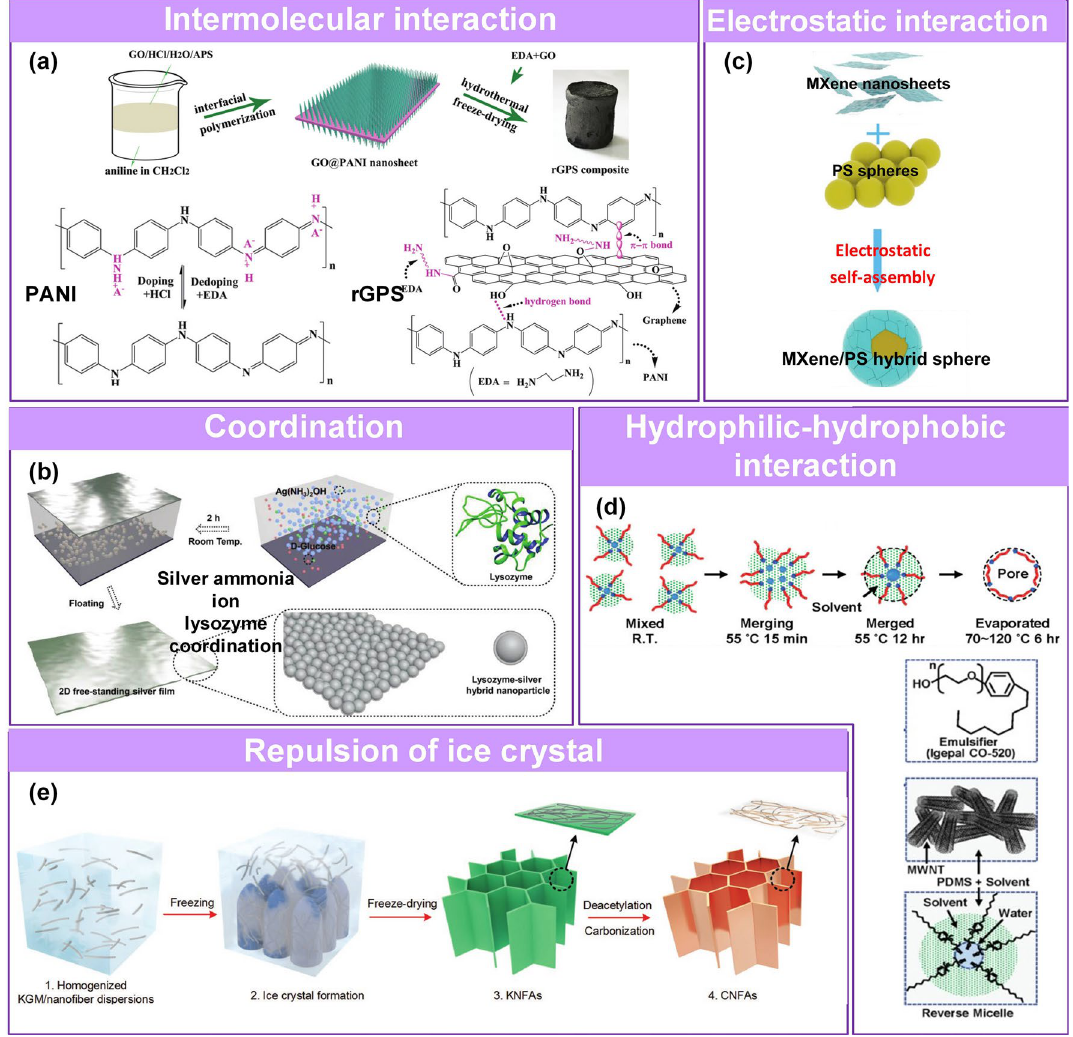
Fig. 13 Self-assemble synthesis of structured sensing materials. Self-assembly process based on a Intermolecular interaction of the interac- tions of π–π interaction action and hydrogen bond between GO sheets and PANI nanowires [111]. Copyright (2019) Royal Society of Chemistry. b Coordination of Ag NPs and protein at the air/water interface [112]. Copyright (2018) Wiley–VCH. c Electrostatic interaction between PS sphere and MXene [113]. Copyright (2019) Wiley–VCH. d Hydrophilic-hydrophobic interaction to form micelles [26]. Copyright (2014) Wiley– VCH. e Honeycomb-shaped structure guided by growth and repulsion of ice [114]. Copyright (2016)